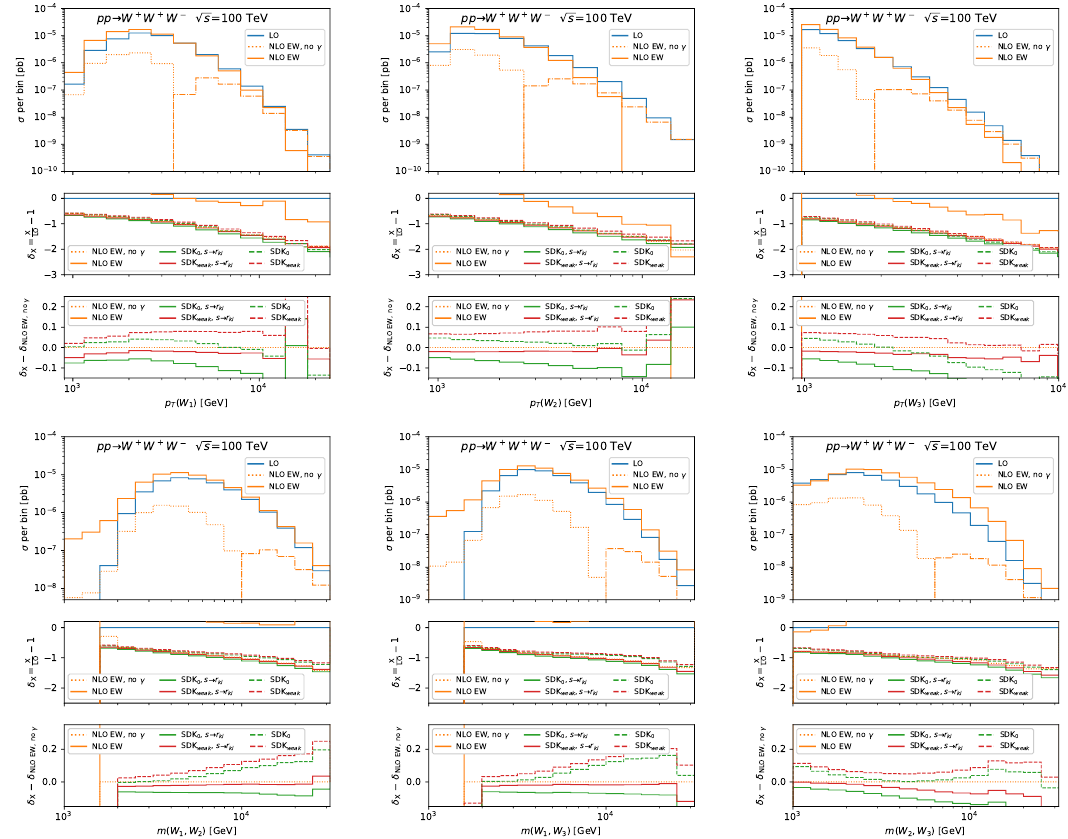
Figure 8 . Same as figure 7, but for W + W + W (cid:0) hadroproduction at 100